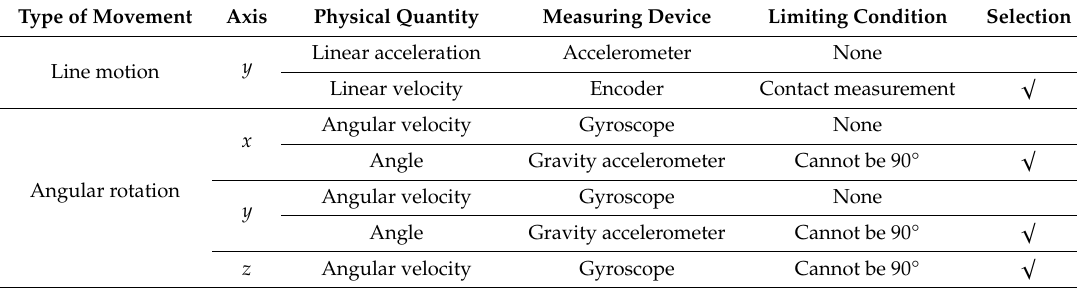
Table 1. Optional physical parameters of measurement.